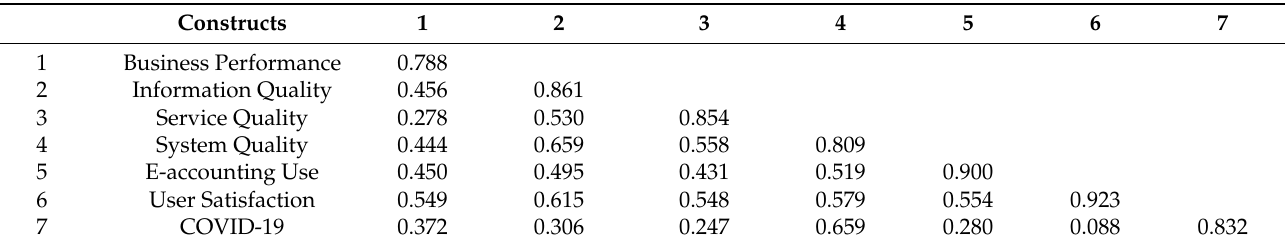
Table 2. Fornell–Larcker Scale (Discriminant Validity Matrix).